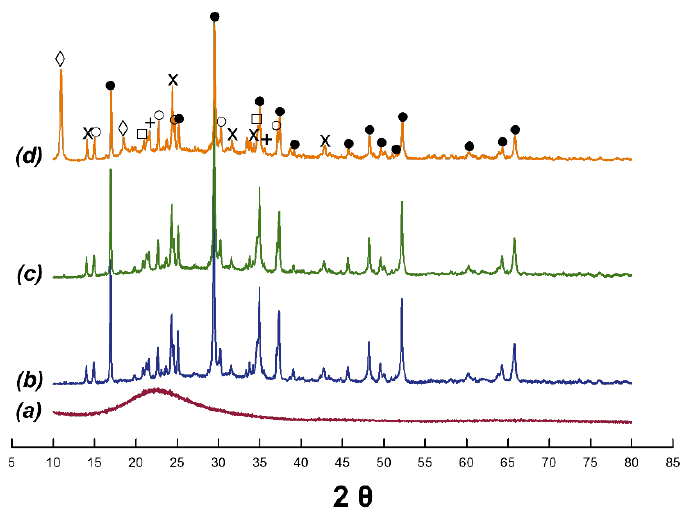
Figure 2. XRD diffractogram of NaNO 3 /SiAl 20:1 catalyst: (line a) support (heat-treated SiAl); (line b) NaNO 3 /SiAl 20:1 without any use; (line c) NaNO 3 /SiAl 20:1 after 3 h in contact with methanol;